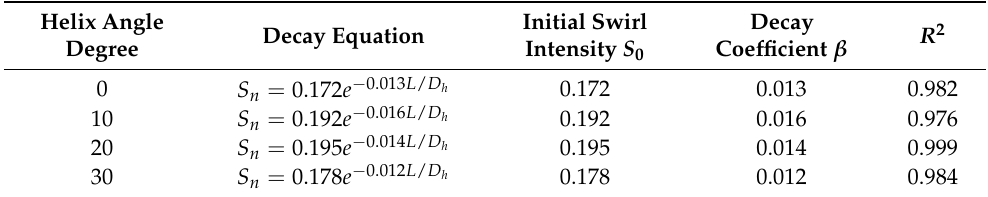
Table 5. Decay equation of spiral flow induced by the hole cleaning device under different helix angles (numerical results).